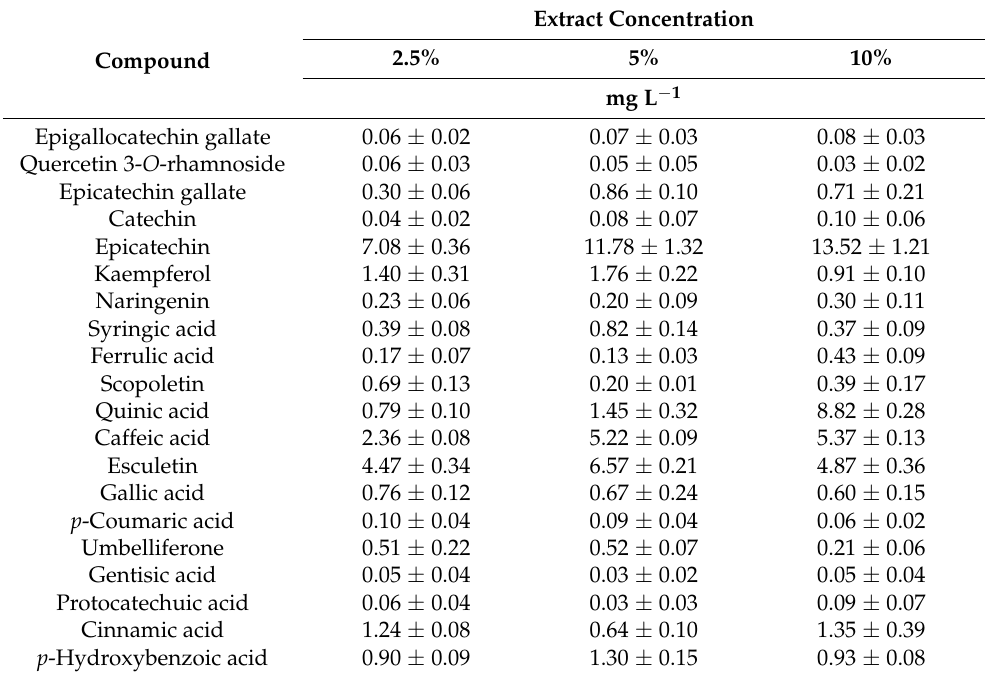
Table 2. Phytochemical composition of black cumin ( N. sativa L.) aqueous extracts of different concentrations.